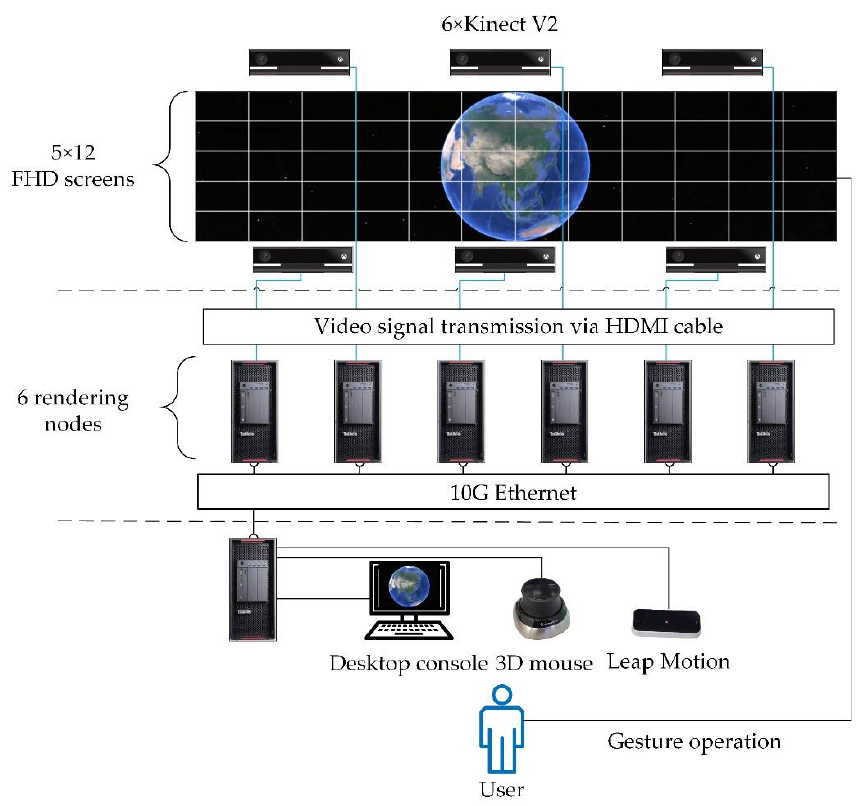
Figure 11. System structure of Liquid Galaxy system.